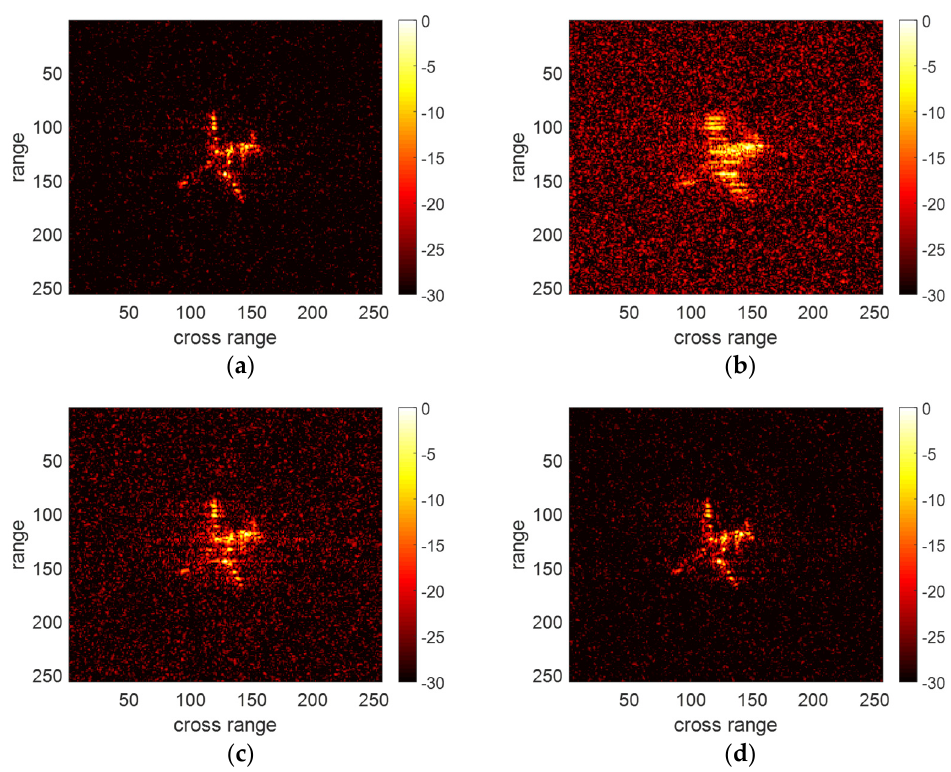
Figure 7. Translational motion compensation result of different methods under SNR = − 3 dB. ( a ) Ideal result. ( b ) Result of PSO. ( c ) Result of PD-KT-FrFT. ( d ) Result of the proposed method.